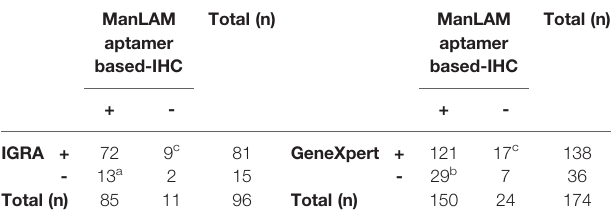
TABLE 2 | High agreement between ManLAM aptamer based- immunohistochemistry (IHC) and IGRA/GeneXpert for tuberculosis (TB) diagnosis. ManLAM